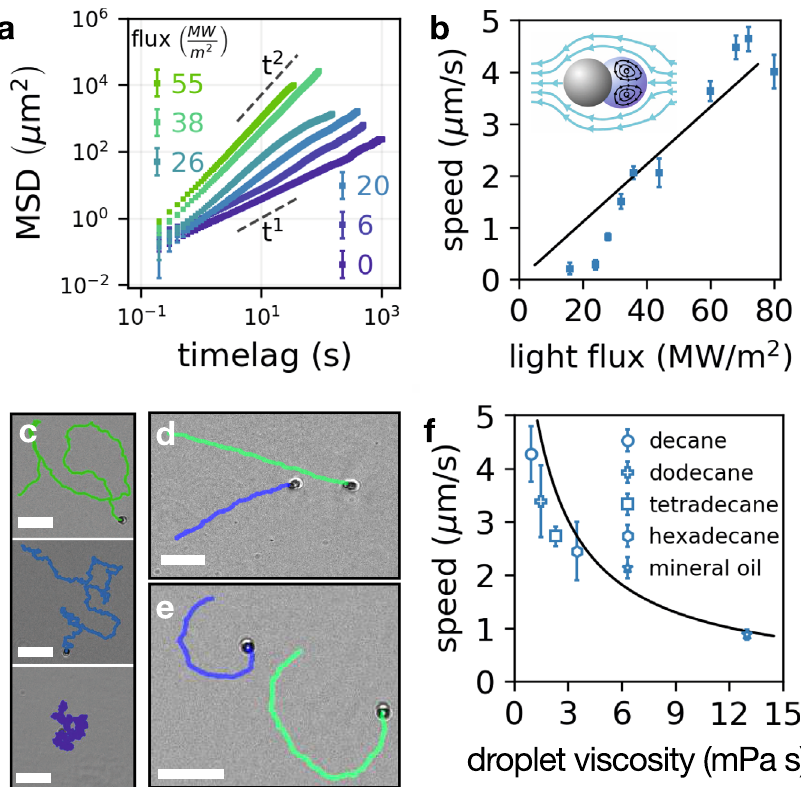
Fig. 2 The internal drive of the fl uid micro-swimmers relies on light-activated thermo-capillary action, independent from a chemical fuel in the surrounding bath. a the mean square displacement (MSD) shows an individual swimmer ’ s motility can be continuously tuned from diffusive ( ∝ t 1 ) to ballistic ( ∝ t 2 ). b the speed of a swimmer scales linearly with the power fl ux of the light source reaching more than one body length per second. Inset illustrates the fl uid- fl ow where the surface-tension gradient drives the liquid – liquid interface to re-circulate (black) and propel the swimmer through the hydrodynamic coupling to the external fl ow (cyan). c with increasing power fl ux, trajectories of free swimmers show the transition from random (bottom) to more ballistic (top) motion. Using an external magnetic fi eld the orientation of a swimmer can be controlled to move on a straight line ( d ) or in circles ( e ) allowing direct measurement of the nominal swimming speed. f increasing the internal viscosity of the fl uid droplet directly reduces the speed of the swimmer. The solid line is the theoretically predicted swimming speed using no fi tting parameters (full characterization of optical absorption and thermo- capillary measurements are found in Supplementary Information). Scale bars: 20 μ